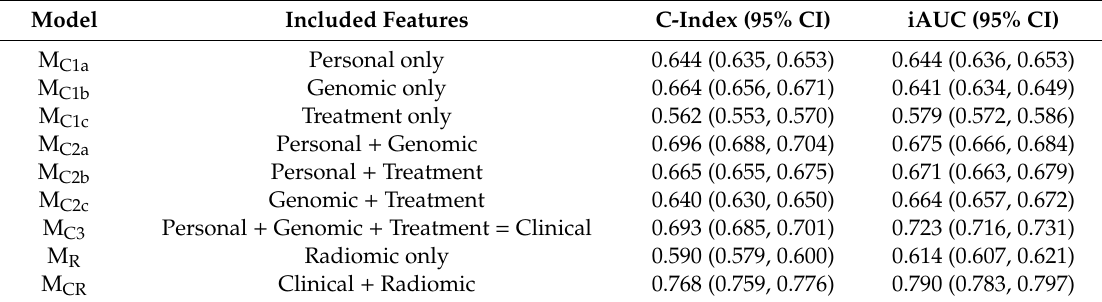
Table 3. Harrell’s concordance index (C-Index) and integrated area under the time-dependent receiver operating characteristic curve (iAUC) values of each model for overall survival prediction.